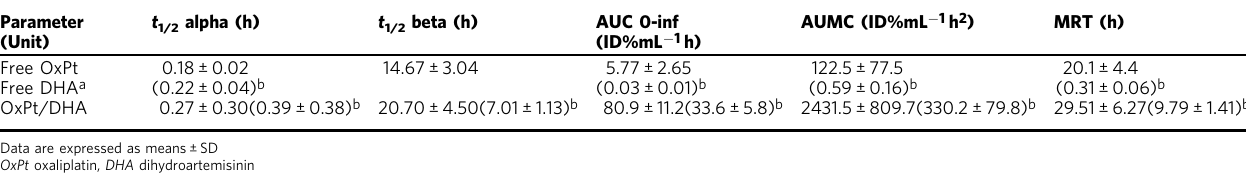
Table 1 OxPt and DHA pharmacokinetic information Parameter